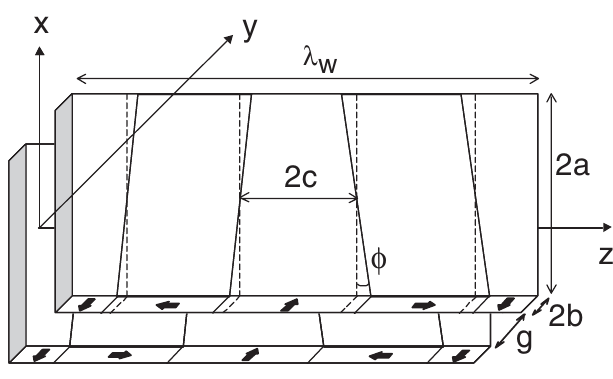
FIG. 1. Schematic drawing of a period of the edge-focusing (EF) wiggler with the edge angle (cid:1)